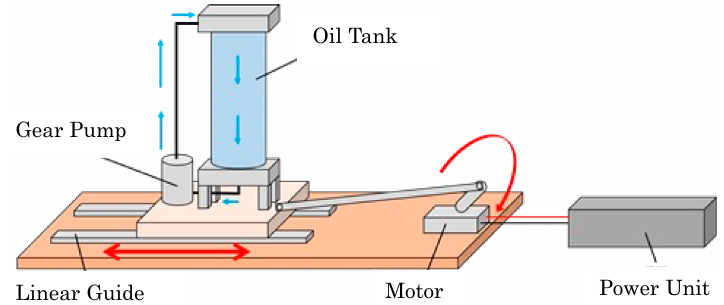
Figure 2. Schematic diagram of experimental apparatus for periodic acceleration.